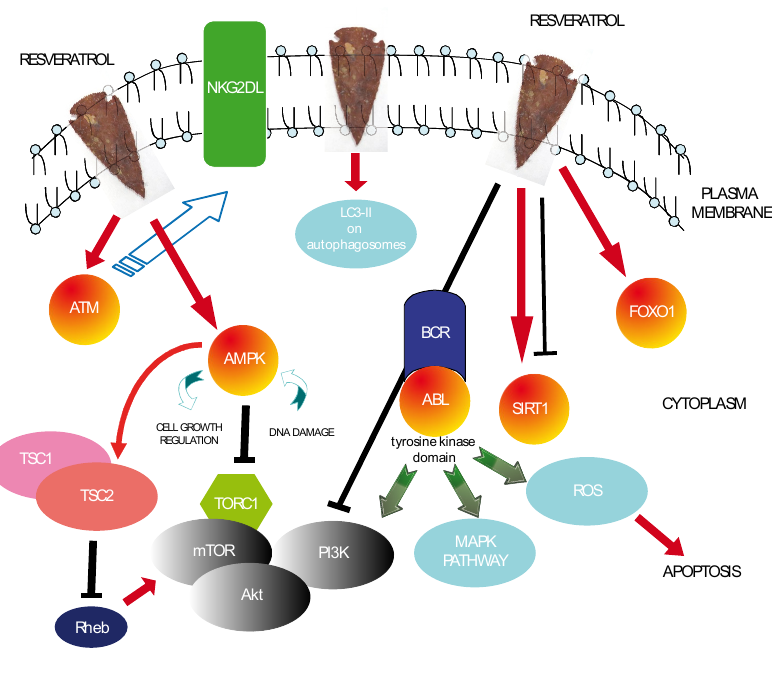
Figure 1. Schematic representation of the recently discovered RSV molecular targets on leukemia or lymphoma cells as described in this paper (ATM, Ataxia telangiectasia mutated; NKG2DL, killer cell lectin-like receptor subfamily K member 1-ligand; LC3-II, microtubule-associated protein 1 light chain 3; AMPK, Adenosine Monophosphate-activated Protein Kinase; TSC1/2, tubular sclerosis 1–tubular sclerosis 2; Rheb, Ras homologue enriched in brain; mTOR, mammalian target of rapamycin; TORC1/2, target of rapamycin complex 1/2; BCR-ABL, breakpoint cluster region protein-c-abl oncogene 1, non-receptor tyrosine kinase; SIRT1, silent information regulator 2 homolog 1; FOXO1, forkhead box protein O1; ROS, reactive oxygen species; MAPK, mitogen-activated protein kinase; PI3K, phosphatidil-inositol 3 kinase; Akt, RAC-alpha serine/threonine-protein kinase). The arrows represent an activation while the T-shaped lines represent an